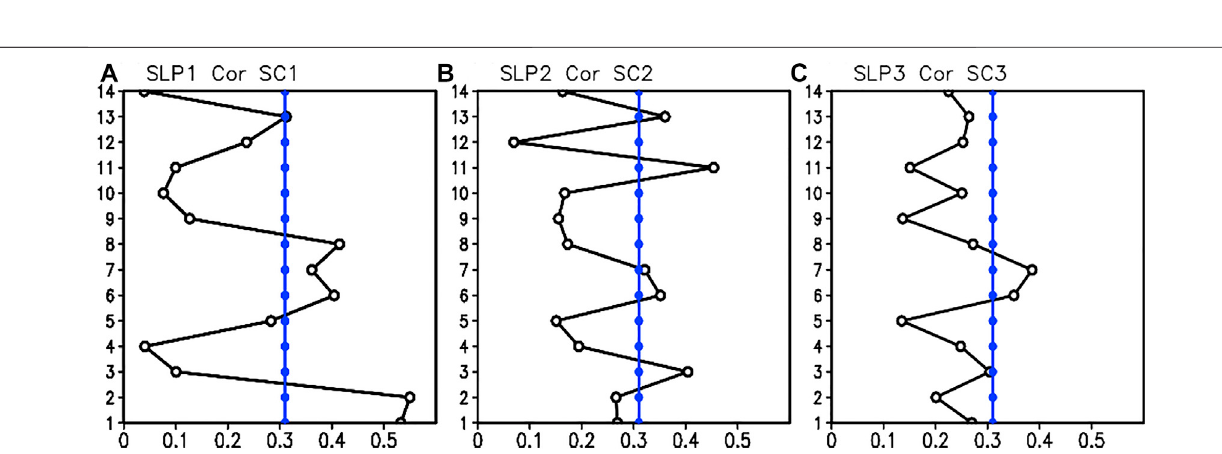
Frontiers in Earth Science |